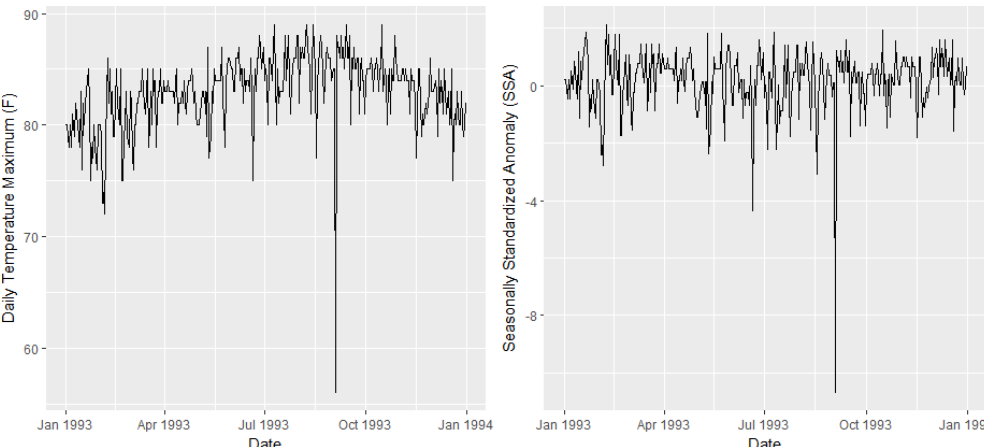
Figure 3. Daily temperature maxima from 2008 (left) and the corresponding SSA series (right) at the Adjuntas Substation in Puerto Rico. This figure was created using Wickham